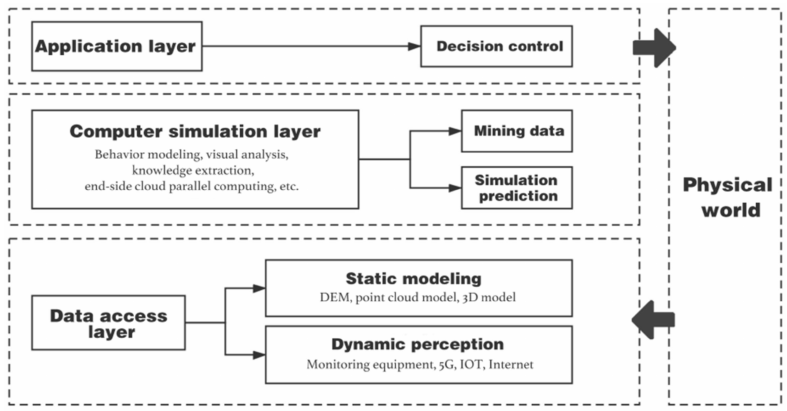
Figure 2. Digital twin technology